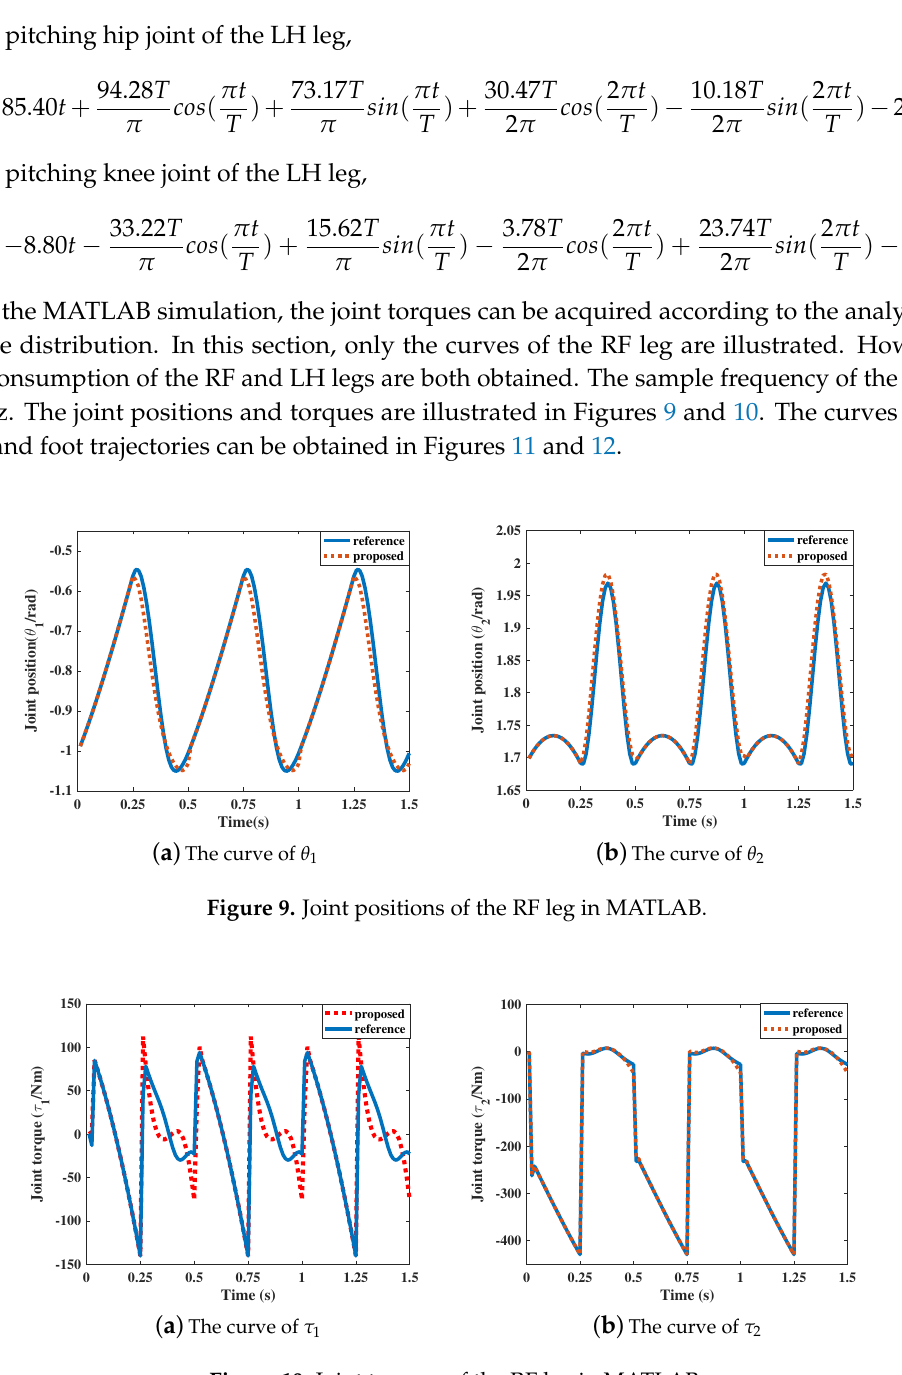
Figure 10. Joint torques of the RF leg in